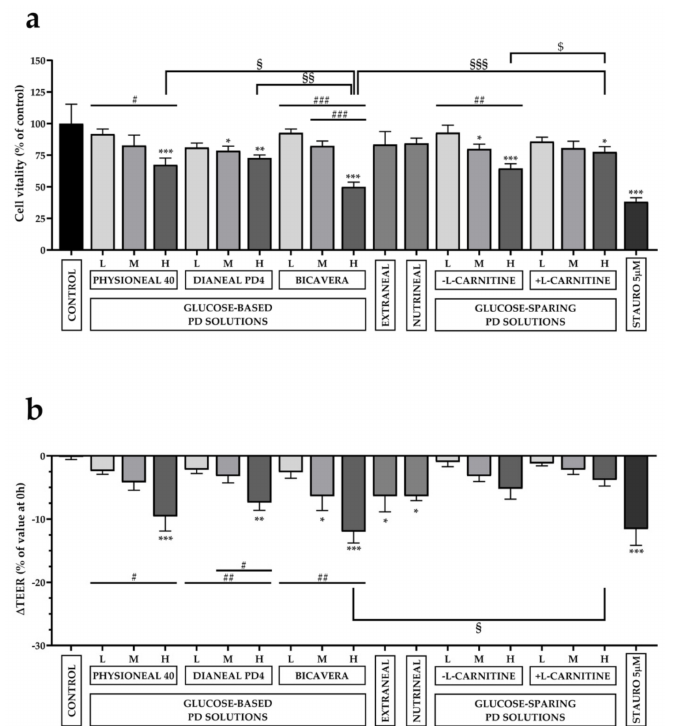
Figure 1. Effects of PD solutions on cell viability and TEER in HMC. Cells were exposed to low, medium and high (L, M, H) osmolarity glucose-based solutions (Physioneal 40 ® , Dianeal PD4 ® , BicaVera ® ), to glucose-free solutions (Extraneal ® , Nutrineal ® ), and to low, medium and high (L, M, H) osmolarity glucose-sparing XyloCore solutions ( ± L -carnitine) for 8 h. ( a ) MTT assay was performed to evaluate cell viability. Cells incubated with Prigrow I medium were used as a control, and their cell viability set to 100%. Staurosporine (5 µ M) served as a negative control of cell viability. ( b ) TEER was measured on each monolayer before and after incubation with PD solutions. Reductions of TEER ( ∆ TEER) were expressed as % of the value measured before exposure to the PD solutions. Significance was analyzed using a one-way ANOVA. Values are expressed as mean ± SEM. ( n = 5). * p < 0.05; ** p < 0.01; *** p < 0.001 indicate statistical significance respect to control cells by one-way analysis of variance (ANOVA) with Dunnett’s multiple comparison test; # p < 0.05; ## p < 0.01; ### p < 0.001 values calculated by one-way analysis of variance (ANOVA) with Sidak’s multiple comparisons test, indicating how much the results differ within the same formulation as the glucose concentration varies. § p < 0.05; §§ p < 0.01; §§§ p < 0.001; values calculated by one-way analysis of variance (ANOVA) with Sidak’s multiple comparisons test, indicating how much the results differ from other treatment with the same concentration of glucose and same osmolarity. $ p < 0.05 values calculated in HMC incubated ± L -carnitine by t